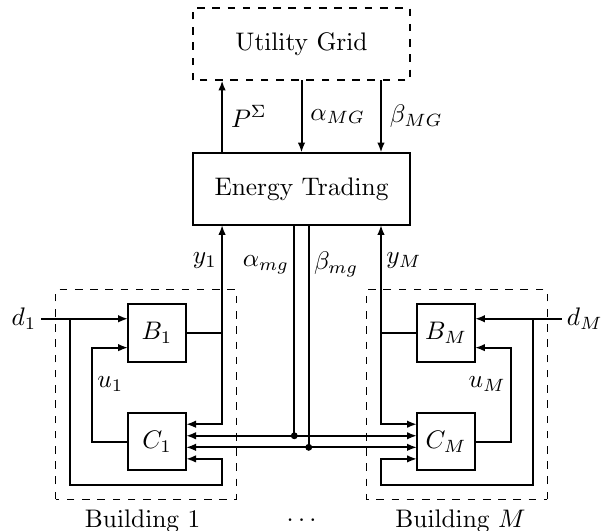
Figure 3. Block diagram of signal flows of a controlled building thermal